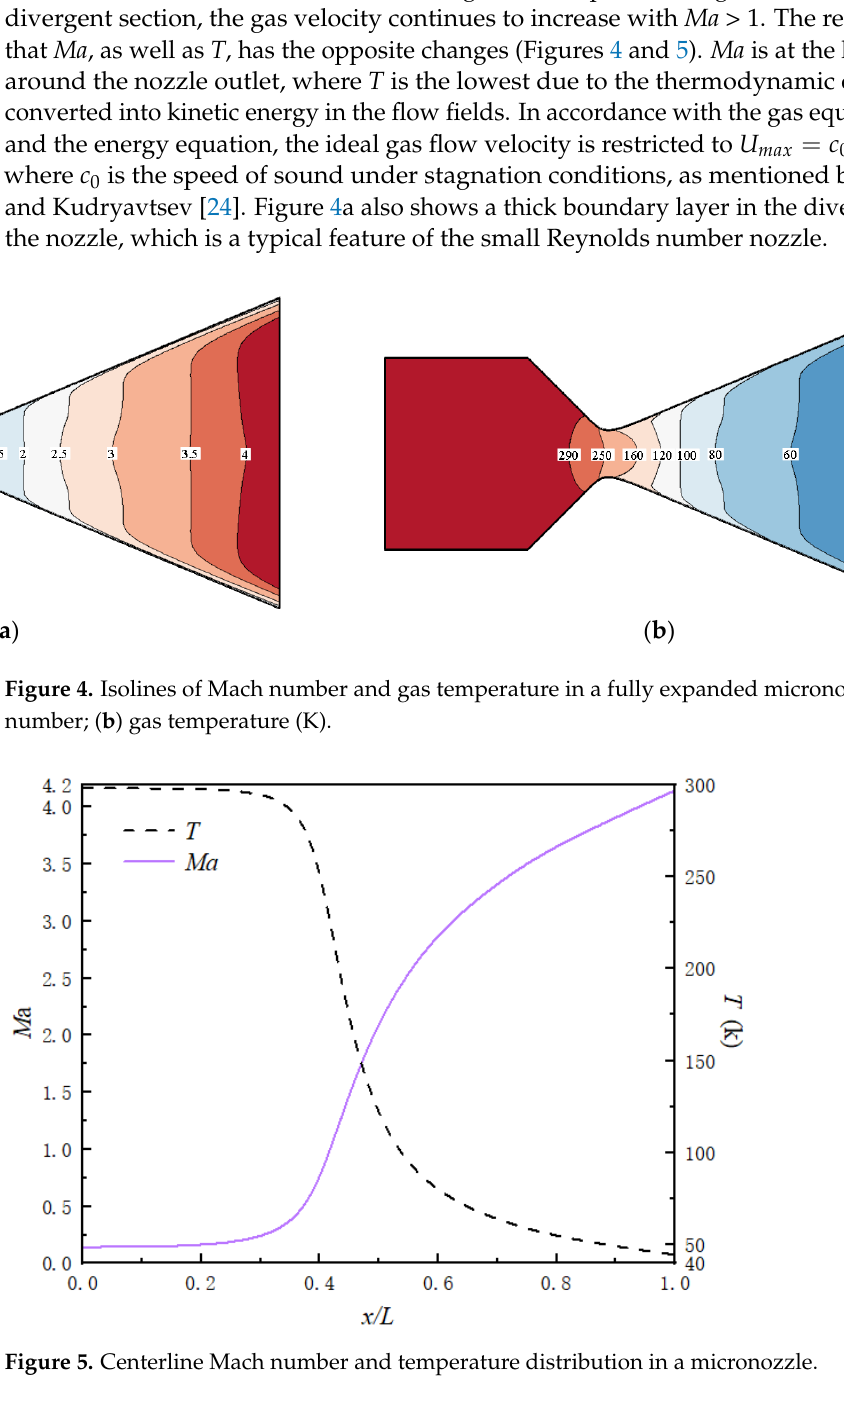
Figure 5. Centerline Mach number and temperature distribution in a micronozzle.